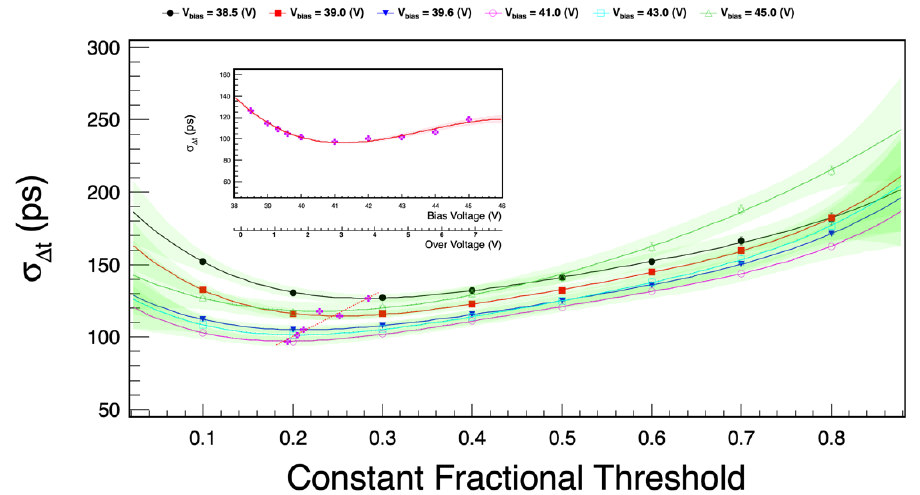
Figure 11. CTR as a function of the constant fractional threshold for different bias voltages. The minimum CTR values (magenta points) are distributed around a constant fractional threshold between 0.2 (20%) and 0.3 (30%). As depicted by a dotted linear fit line, it shifts from 0.3 to 0.2 as the bias voltage increases. The inlay indicates the minimum CTR as a function of the bias voltage and the overvoltage ( ∆ V ). The best CTR for 0.5 MeV electrons reveals ( 96.4 ± 0.4 ) ps at ∆ V = 3.25 V. The colored error band indicates the 95% confidence level of the